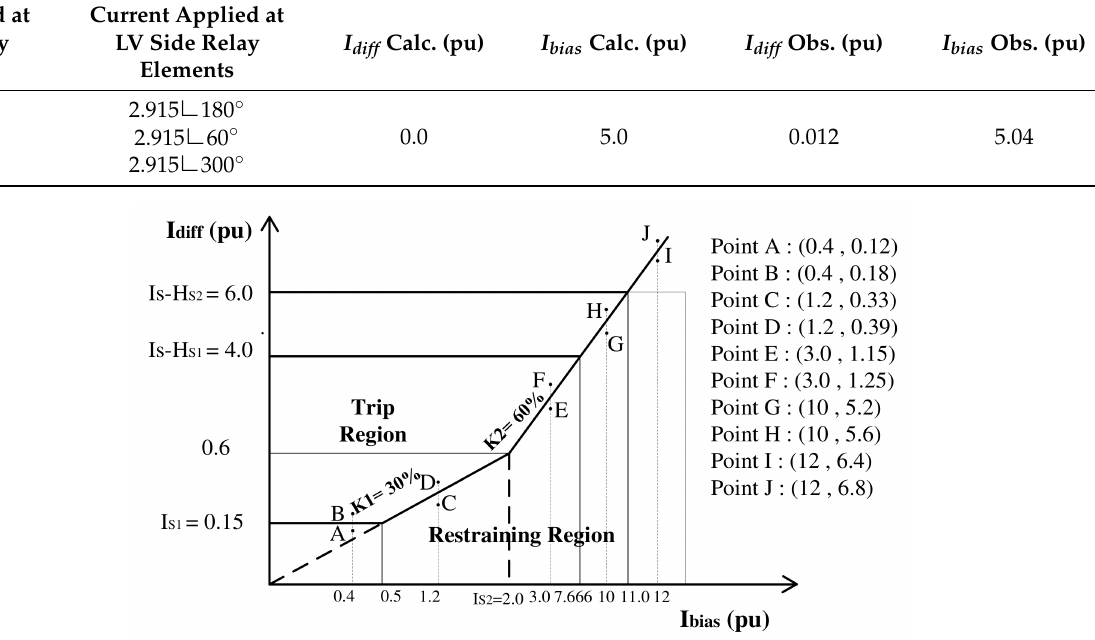
Figure 8. Differential characteristics or bias characteristics with selected points.